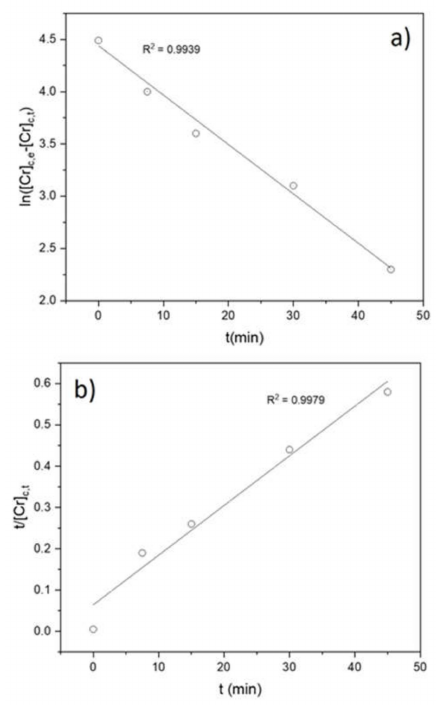
Figure 8. Pseudo-first-order ( a ); and pseudo-second-order ( b ) kinetics models for Cr(VI)